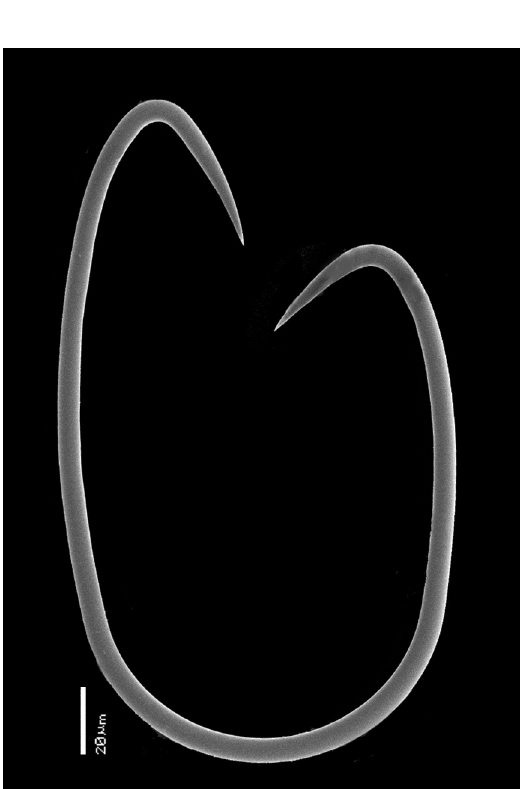
Fig. 1. Flagellosigma, the charac- teristic feature of Haliclona ( Flagellia ) subgen. nov., showing meristic and descriptive features used in this study.